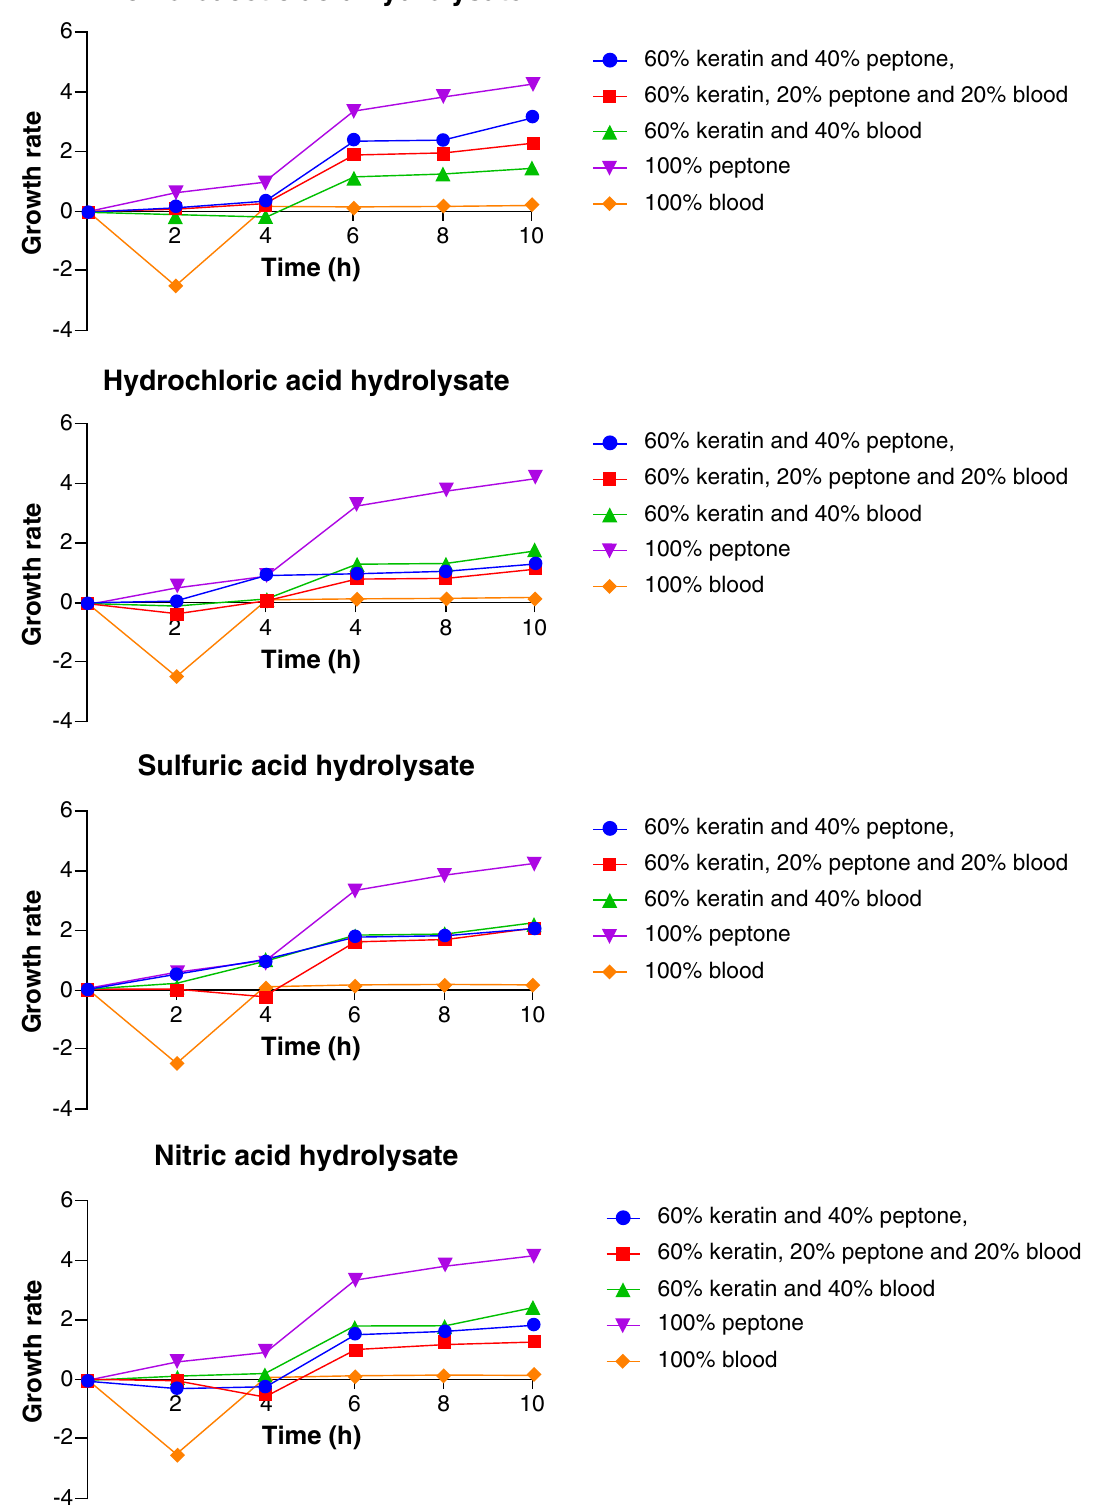
SO and HNO 2 4 3